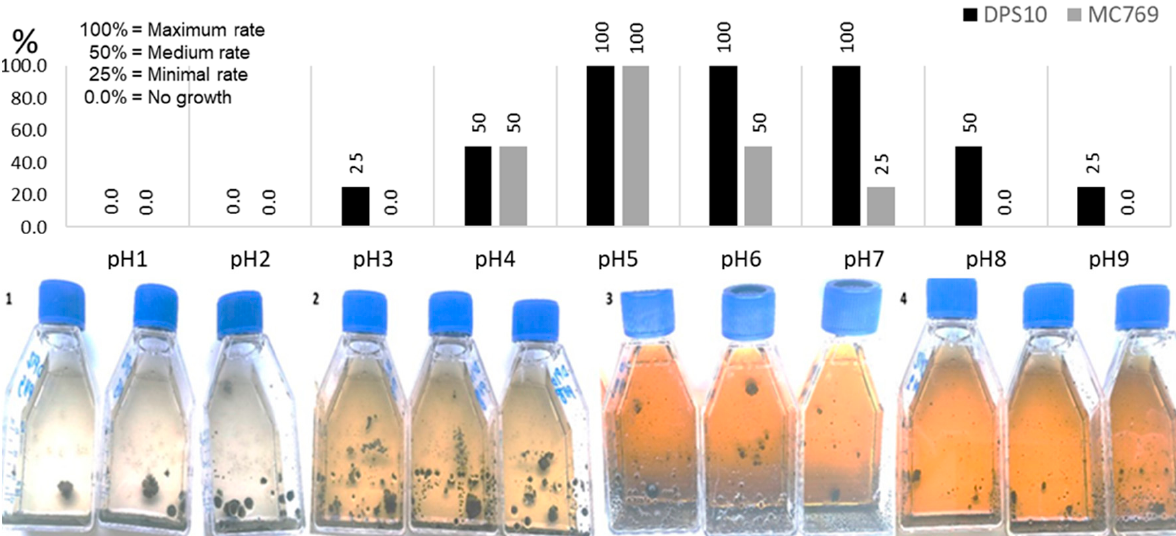
Figure 5. The pH growth range of Pseudotaeniolina globosa DPS10 isolate shown by four established growth grades (0.0, 25%, 50%, 100%) reached on Malt Extract Broth (MEB) medium after one ‐ month incubation at 25 °C. Column chart in the upper part exhibits comparison of DPS10 and MC769 isolates measured at pH 1.0 to pH 9.0. Flasks in the lower part show growth at pH 4.0 (1), pH 6.0 (2), pH 8.0 (3), and pH 9.0 (4). Data on MC769 isolate come from De Leo et al. [16].